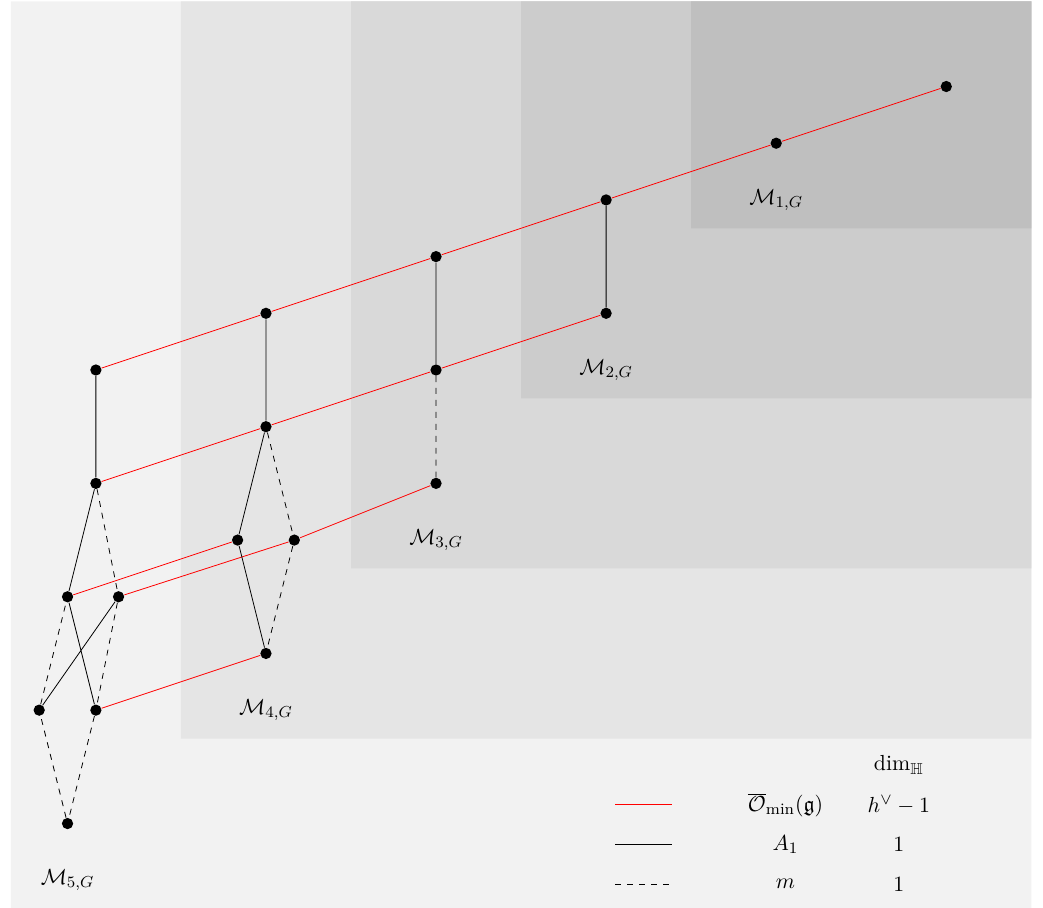
Figure 1. Hasse diagrams for the moduli spaces M k,G of k G -instantons on R 4 for 1 ≤ k ≤ 5 . Only three types of elementary slices show up: the closure of the minimal orbit of the Lie algebra of G , the Kleinian singularity A 1 := C 2 / Z 2 and the non-normal m (see appendix A for the definition of m ). The quaternionic dimension of the transverse slice from the bottom to the top leaf of M is k · ( h ∨ − 1) + ( k − 1) · 1 = kh ∨ − 1